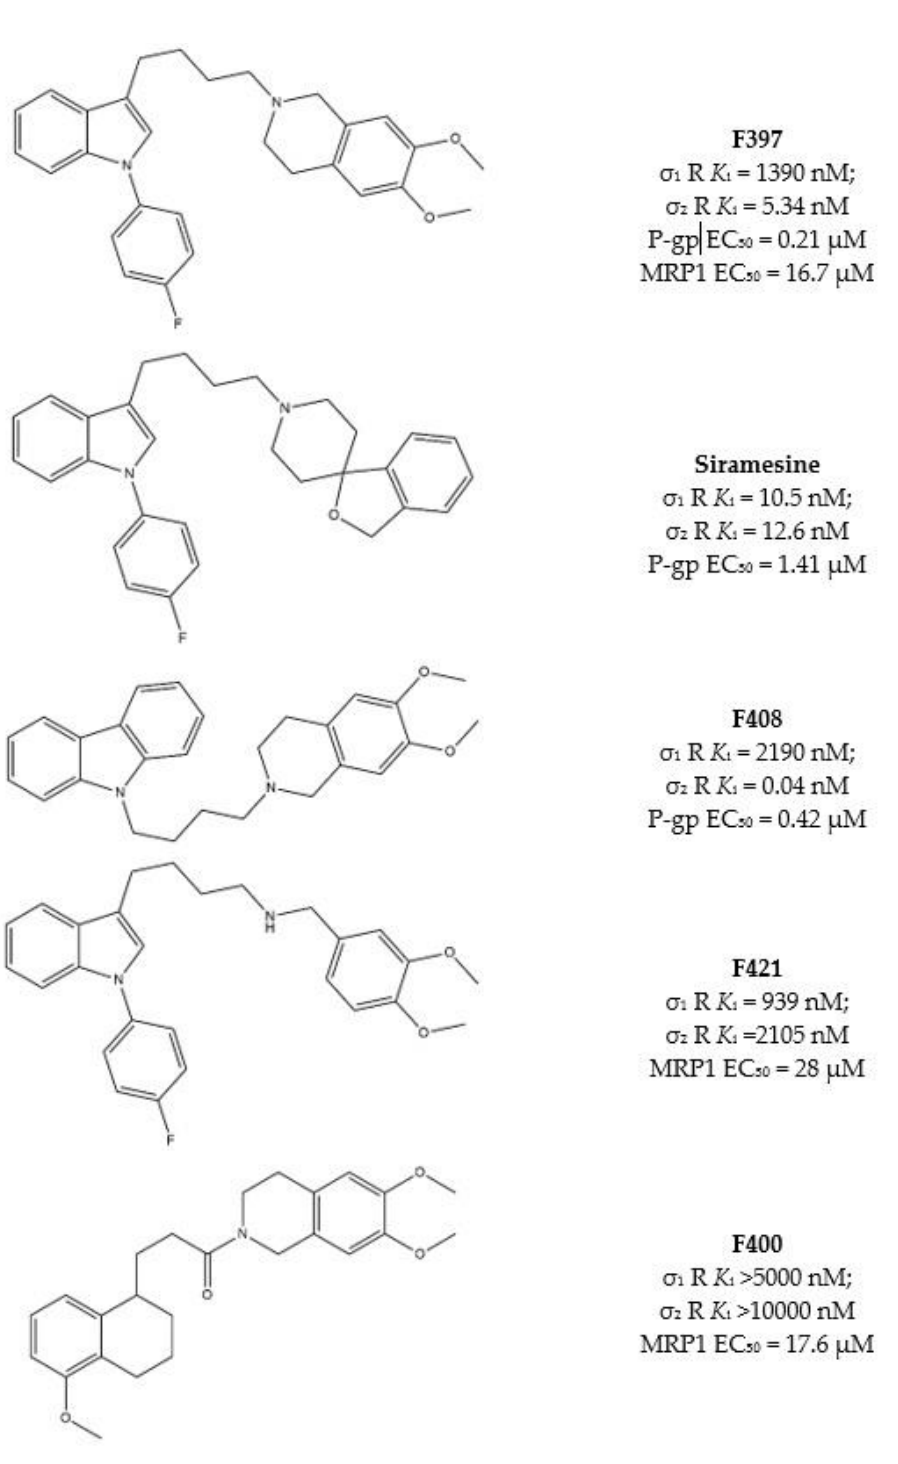
Figure 5. F397, Siramesine, F408, F421 and F400 structures and K i values for σ receptors, EC 50 for P-gp or MRP1. These compounds were investigated in other cell lines couples, such as HT29/HT29dx (colorectal cancer) and A549/A549dx (lung cancer) providing results in ac- cordance with the CS exerted in MCF7 cell lines pairs. Again, F408 and Siramesine demon- strated their CS properties, which were exceptionally important in the HT29 cell lines pair for F408. Indeed, in HT29dx the carbazole derivative F408 produced a 60% cell death at 1 µM concentration. Moreover, studies performed on the mitochondrial respiratory chain revealed that treatment of resistant cells with F408 and Siramesine reduced electron flux and ATP supply, so that these ligands are able to activate multiple cytotoxicity mecha- nisms [91] and appear as MTDLs worthy to be explored to overcome MDR.